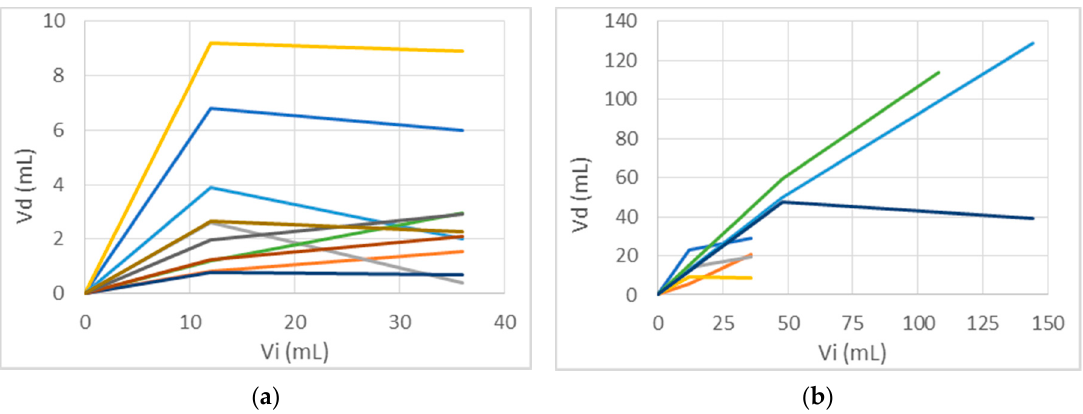
Figure 13. Diminishing returns. ( a ) Distribution volume vs. infusion volume of Gd-DTPA in D2C7